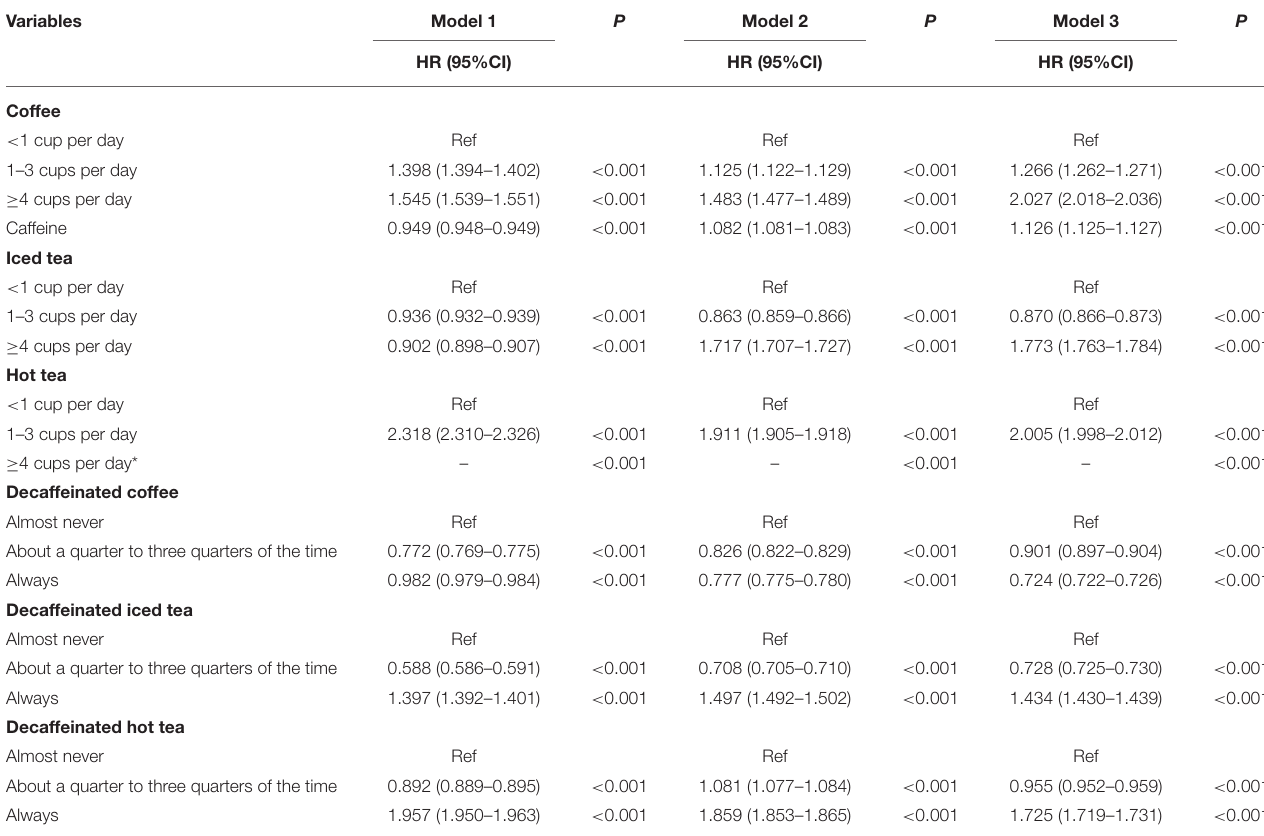
TABLE 4 | The related factors with the risk of the CVD death in CVD population.